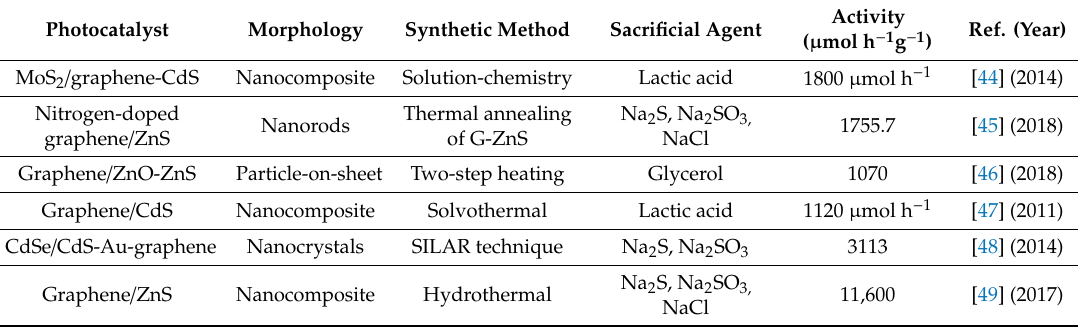
Table 5. Photocatalytic H 2 production properties of graphene-loaded composite